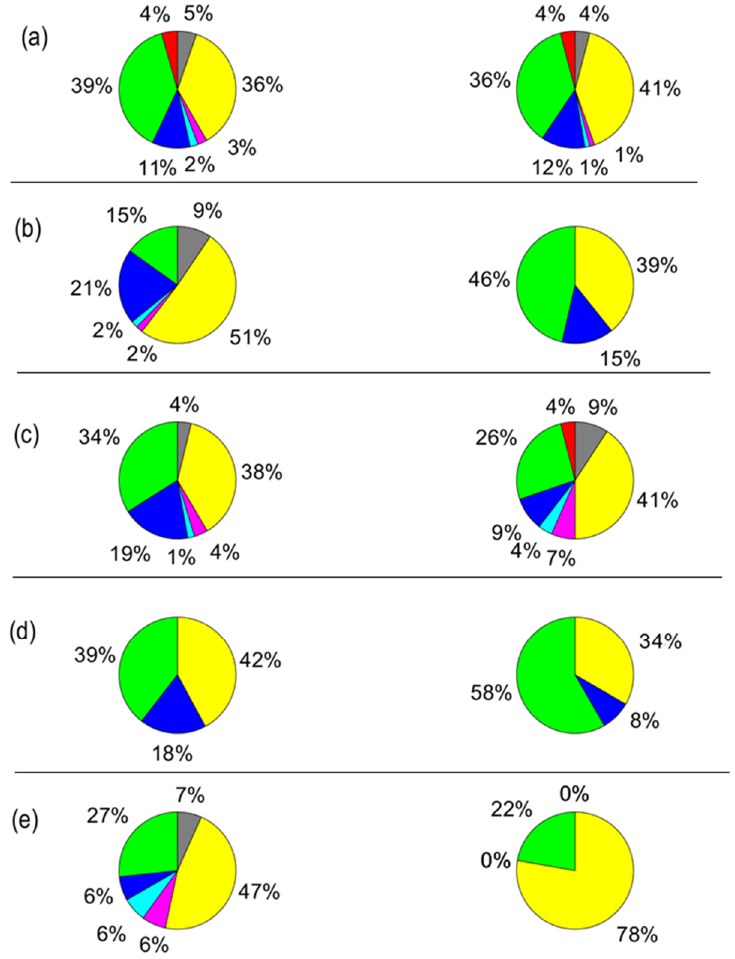
Figure 4. Device combinations used by male (left column) and female (right column) students in the schools: ( a ) Engineering, ( b ) Technology, ( c ) Business, ( d ) IT and ( e ) Music. Legend: green is laptop only, blue is smart phone only, red is desktop only, yellow is laptop+phone combination, cyan is laptop+phone+desktop combination, magenta is laptop+desktop combination, grey is phone+desktop. Note, percentage shown in each figure is rounded to nearest whole number and hence the total may or maynot be equal to 100%.